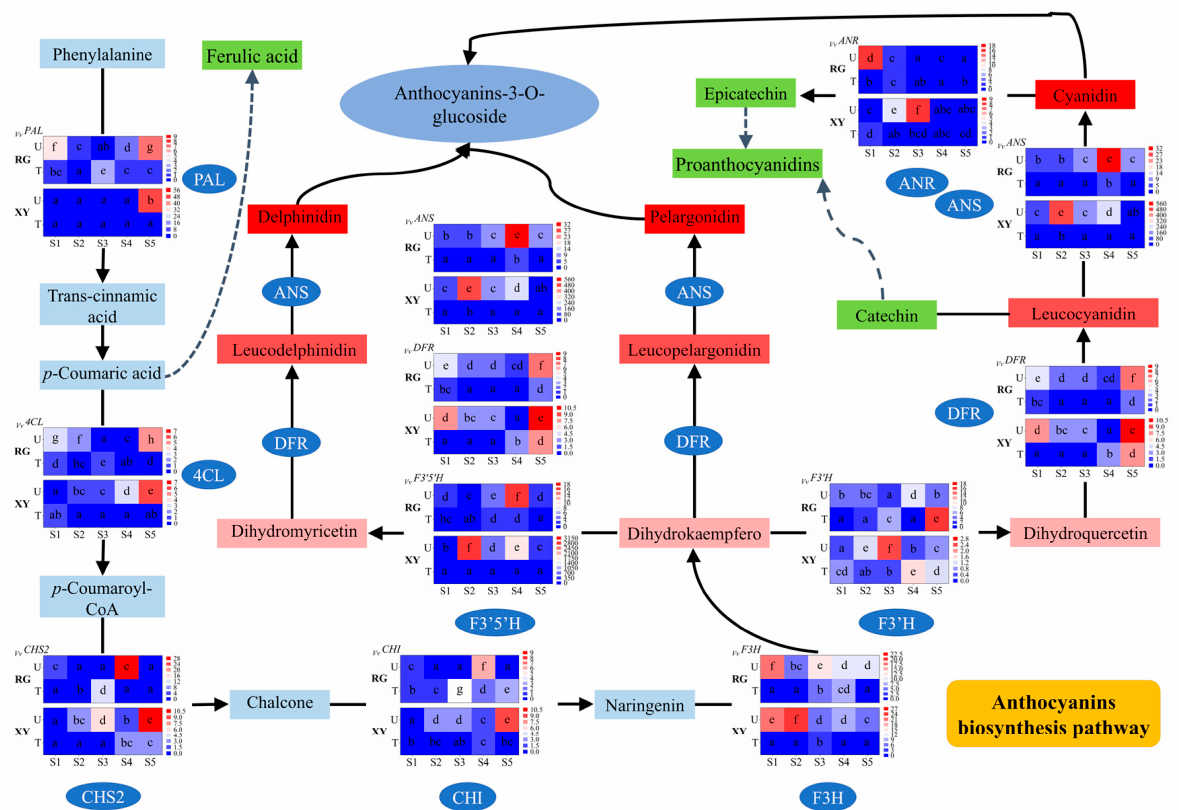
Figure 1. Gene relative expression levels of the anthocyanin biosynthesis pathway in grape berries during the five developmental stages in Urumqi and Turpan. The data presented are as mean ± SD of triplicates. PAL encodes phenylalanine ammonia lyase; 4CL encodes 4-coumarate-CoA ligase; CHS2 encodes chalcone synthase; CHI encodes chalcone isomerase; F3H encodes flavanone 3-hydroxylase; F3 (cid:48) H encodes flavonoid-3 (cid:48) -hydroxylase; F3 (cid:48) 5 (cid:48) H encodes flavonoid-3 (cid:48) 5 (cid:48) -hydroxylase; DFR encodes dihydroflavonol-4-reductas; ANS encodes anthocyanin synthase; and ANR encodes anthocyanidin reductase. RG stand for ‘Red Globe’ grapes; XY stand for ‘Xin Yu’ grapes; U stands for Urumqi; T stands for Turpan. Bars with different letters differ significantly at p <